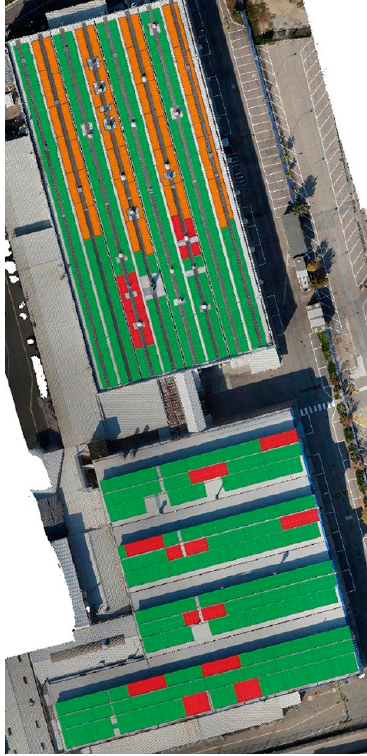
Figure 16. The themed map of a PV system to highlight totally overheated strings (in red) and totally overheated arrays (in orange). (Plant A).